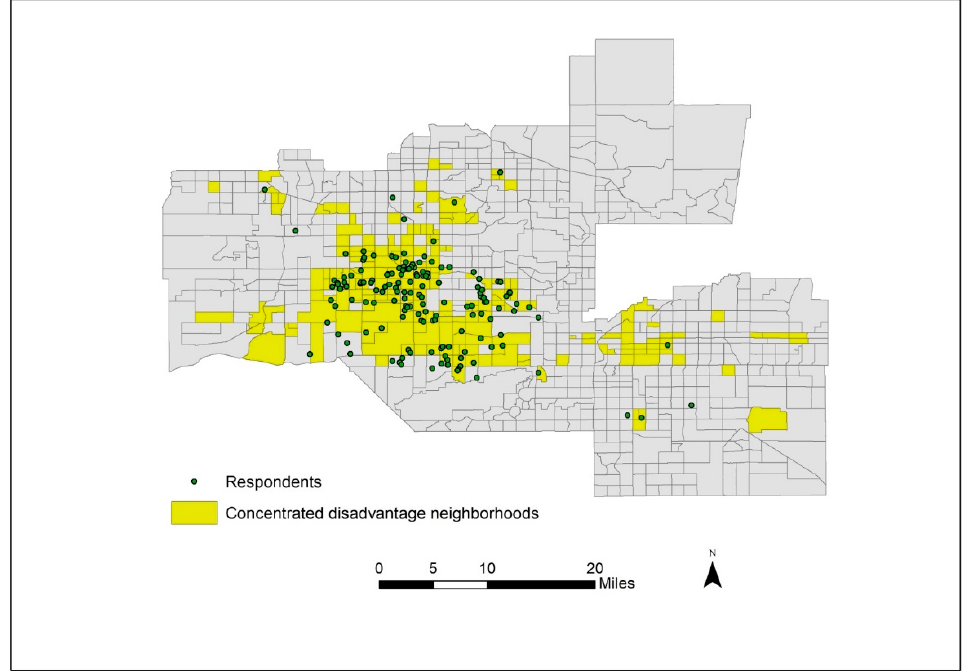
Figure 1. Distribution of Sample and Concentrated Disadvantaged in the Phoenix Chandler Area.